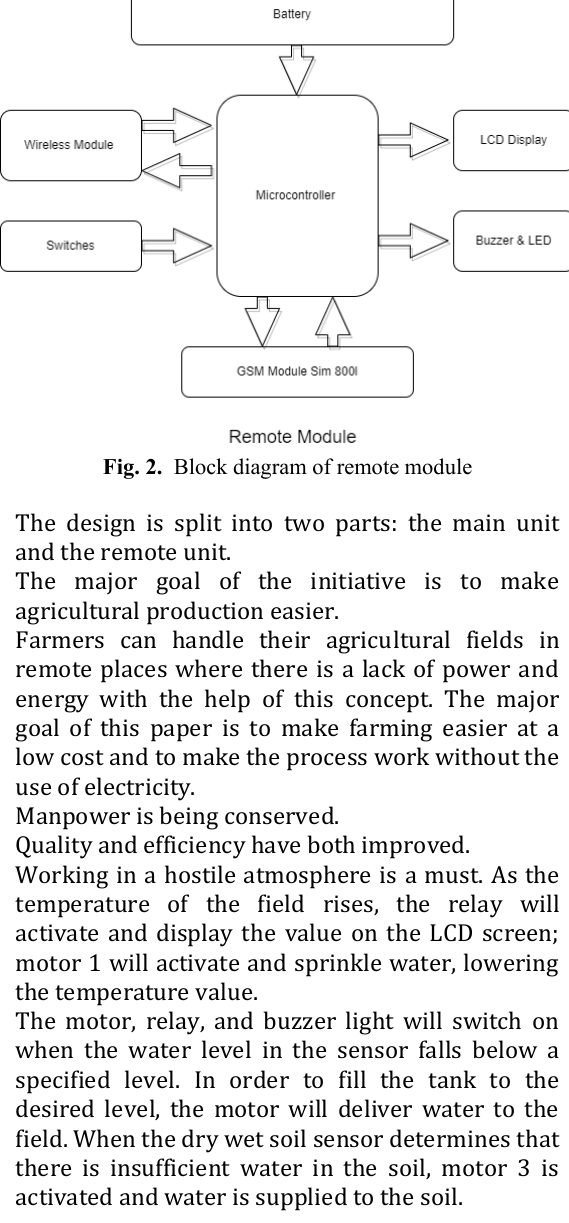
Fig. 1. Block diagram of the main unit